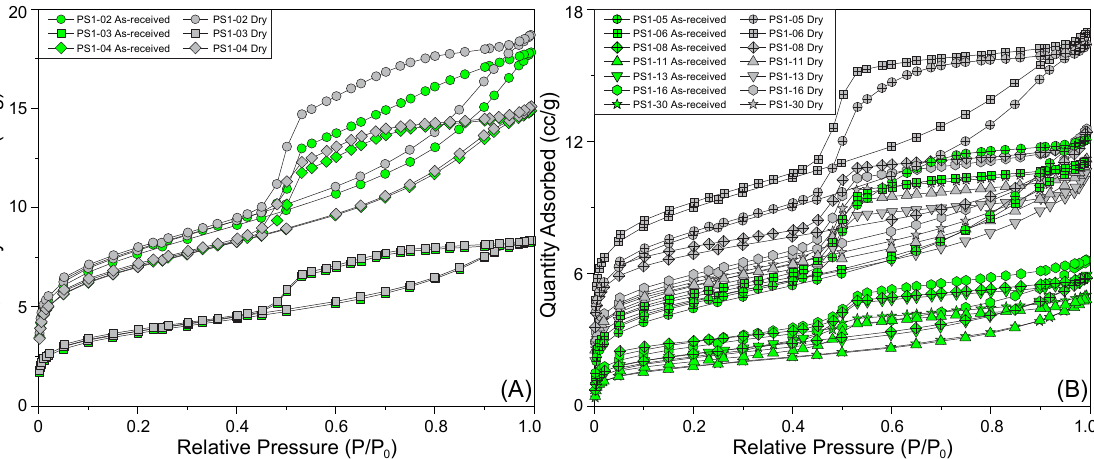
Figure 5. Low-pressure N 2 adsorption isotherms of the as-received and dry shale samples from ( A ) the WF and ( B ) the LMX of the Well PS1.